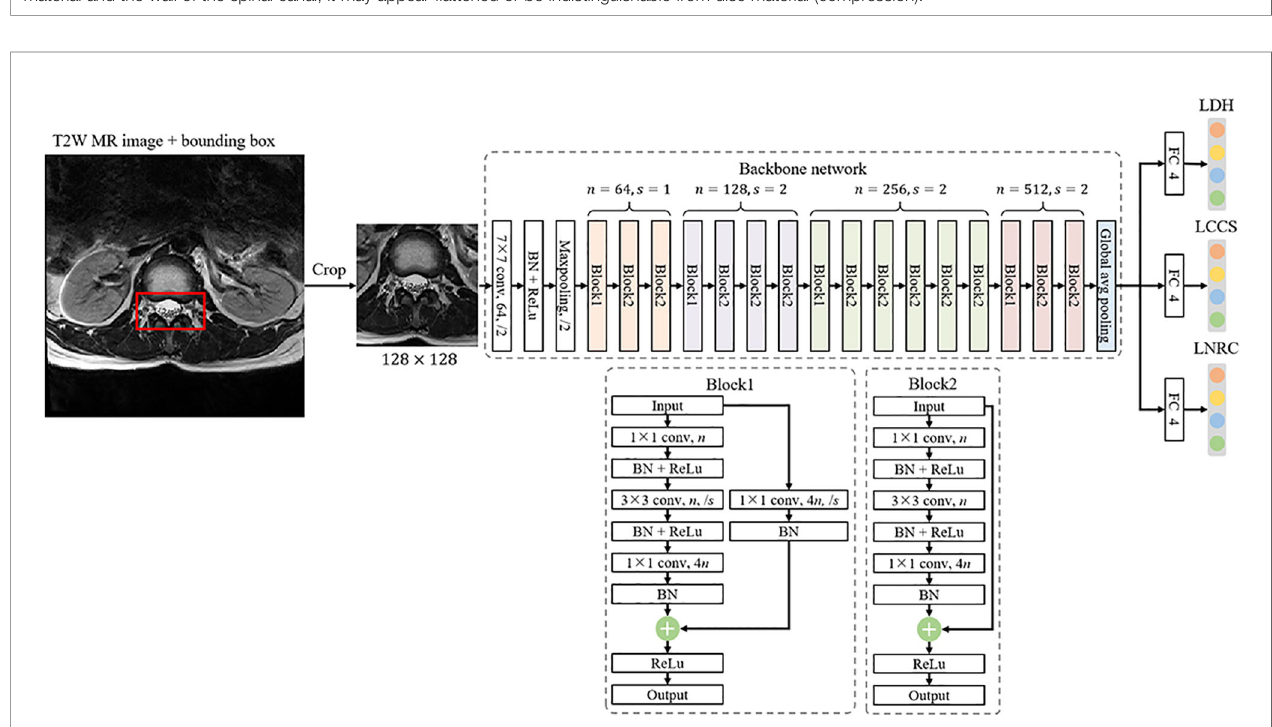
FIGURE 5 | The framework of a multi-task classi fi cation network consists of a backbone network for feature extraction and three fully-connected (FC) networks for classi fi cation, where n denotes the number of output channels and s is the stride of convolution.